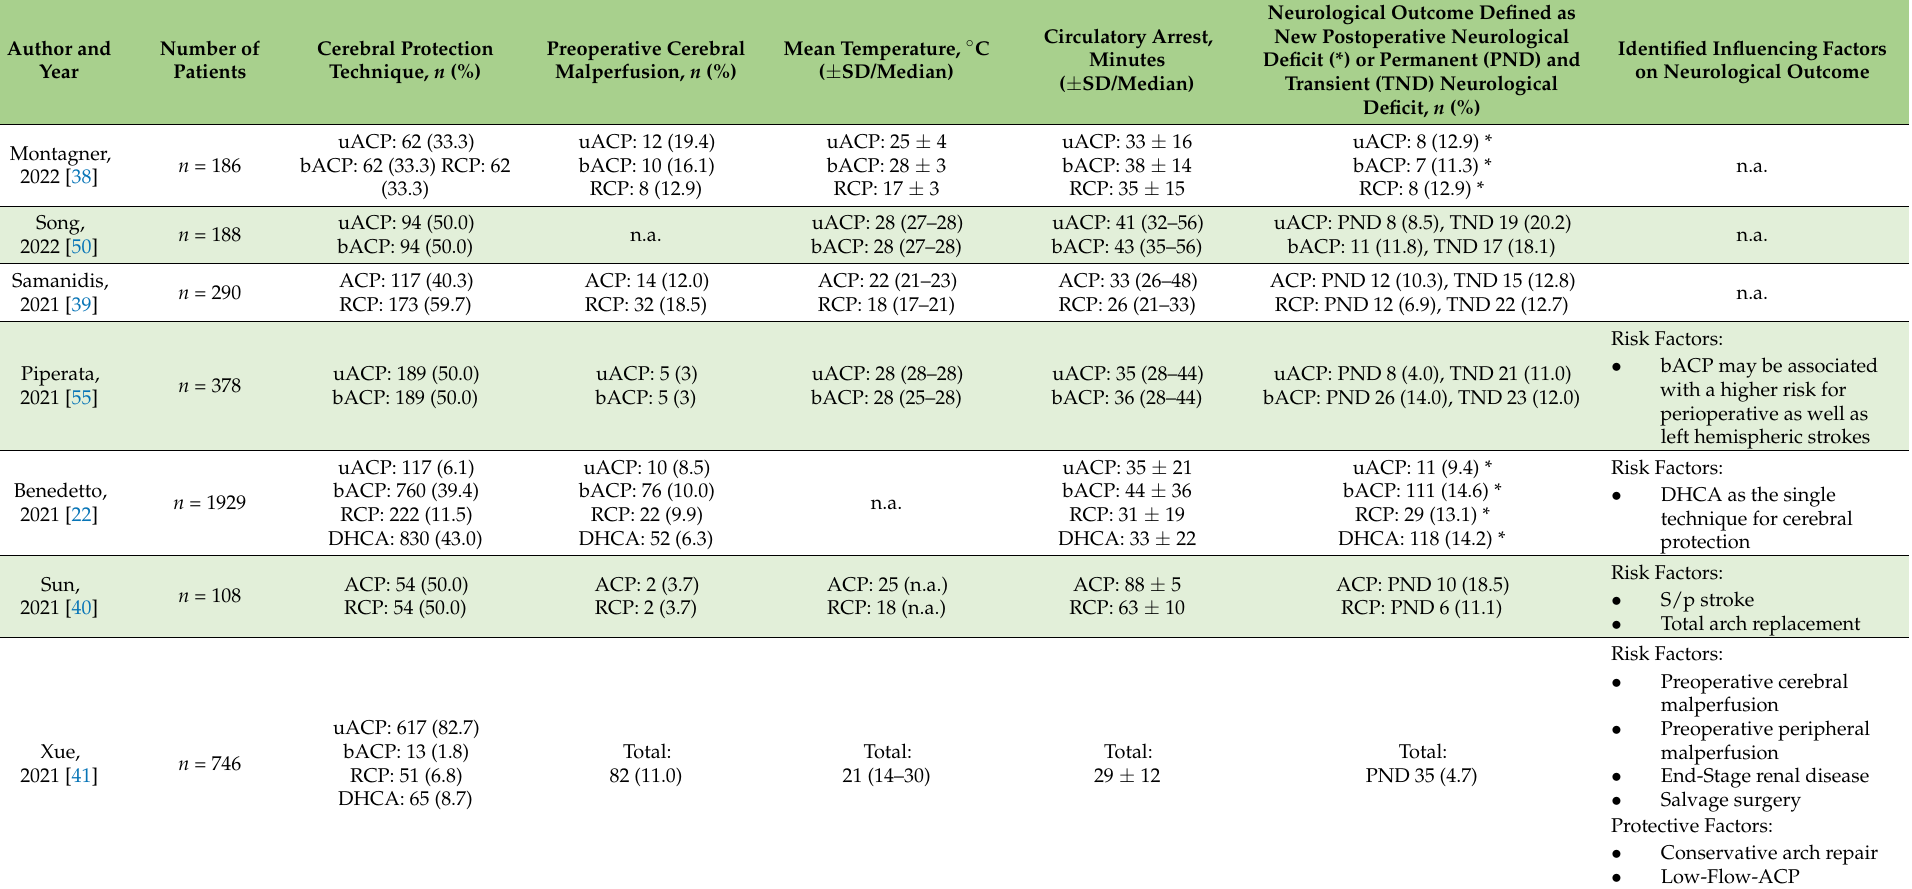
Table 1. Recent Studies Investigating the Neurological Outcome after Surgery for ATAAD Taking into Account the Different Techniques of Cerebral